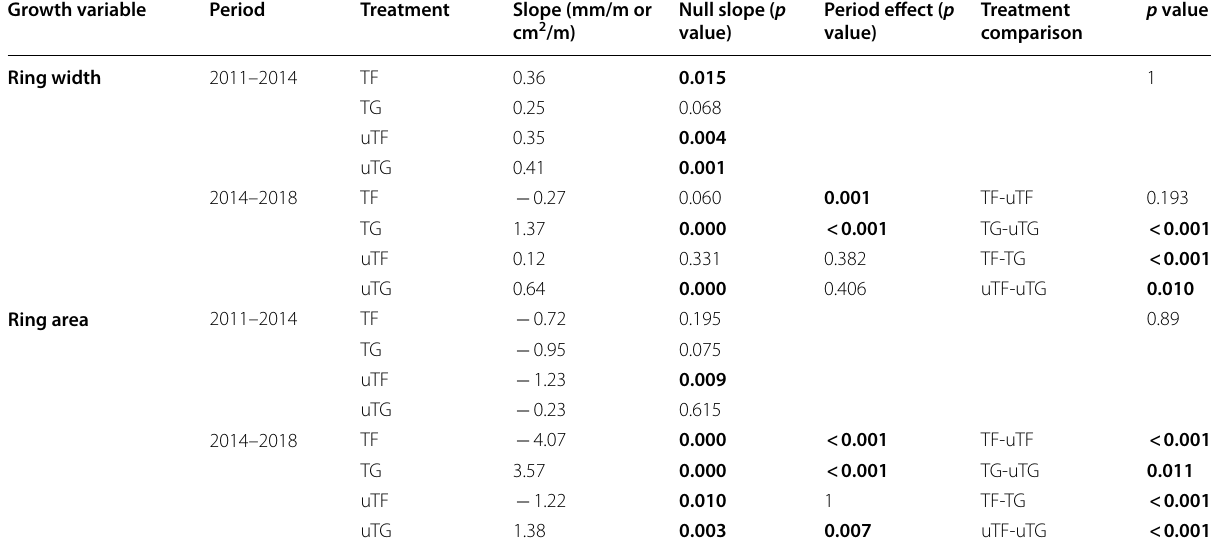
P values refer to the slope significance in the linear model (compared to zero) or Tukey contrasts (period and treatment effects). Significant values are in bold